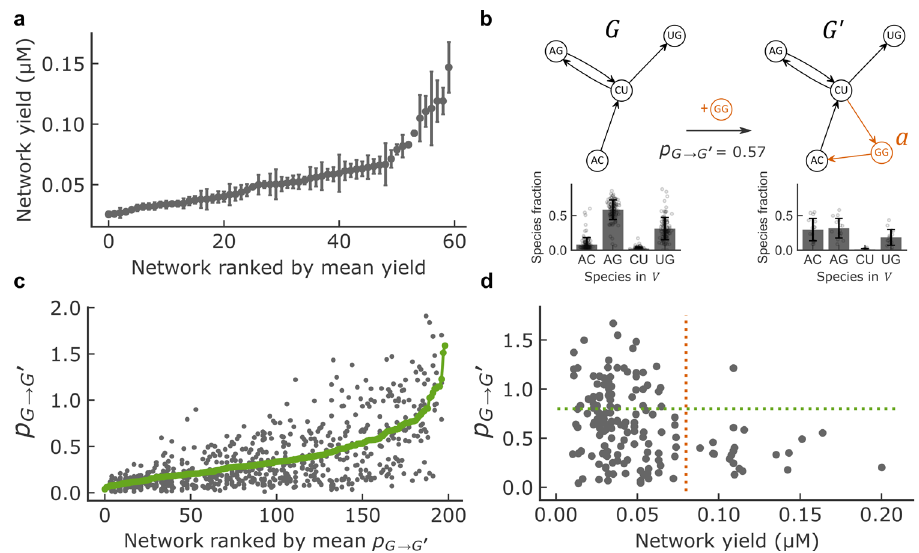
Fig. 2 Network yield and perturbation. a Network total yield (total concentration of WXYZ ribozymes in µ M) distribution of networks with four catalytic species (among the 1820 theoretically possible) that comprise at least 10 replicates. Data on all network sizes is provided in Supplementary Table 2. Networks are ranked from lowest to highest yield ( x -axis) based on the mean across network replicates of the total WXYZ concentration ( y -axis). The error bars show the Standard Error of the Mean. See Methods for further details on network yield determination. b Example showing the addition of catalyst a (GG, orange) to network G resulting in network G ′ . Top: schematic. Bottom: experimentally determined species fractions for the same network (data are represented as mean values ±1 s.d. over n = 109 droplets ( G ) and n = 15 droplets ( G ′ ). c Perturbation distribution of networks with four species. Networks are ranked ( x -axis) based on the mean perturbation ( y -axis). Each position on the x -axis corresponds to a certain network G , for which the perturbation has been computed for all possible single species additions present in the dataset, leading to several y -axis values corresponding to different G ′ networks. The green line is the average perturbation taken overall G ′ networks for each network G . d Perturbation p 5 species plotted against network yield in µ M for perturbations involving the addition of a novel catalysts (with G/C as IGS) with at least one target. The number of strongly perturbable ( p G → G ′ > 0.8, above the green dotted line) and high-yield networks (>0.08 µ M, right hand side of red dotted line) is very low compared to the null hypothesis of independence between the two properties (one-sided Fisher exact test, N = 162, odds ratio <0.1, 95% con fi dence interval 0.01 – 0.66, p -value = 1.6 × 10 − 3 interpreted the change in species fractions induced by the extra species as a perturbation of the network, in the sense that the system with and without the extra species have different fractions of the common species. Note, however, that perturbation of a preformed network by addition of a new species may not result in the same species fractions: if the fi nal reaction network has multiple stable states, its state may depend on the composition before adding the novel species.